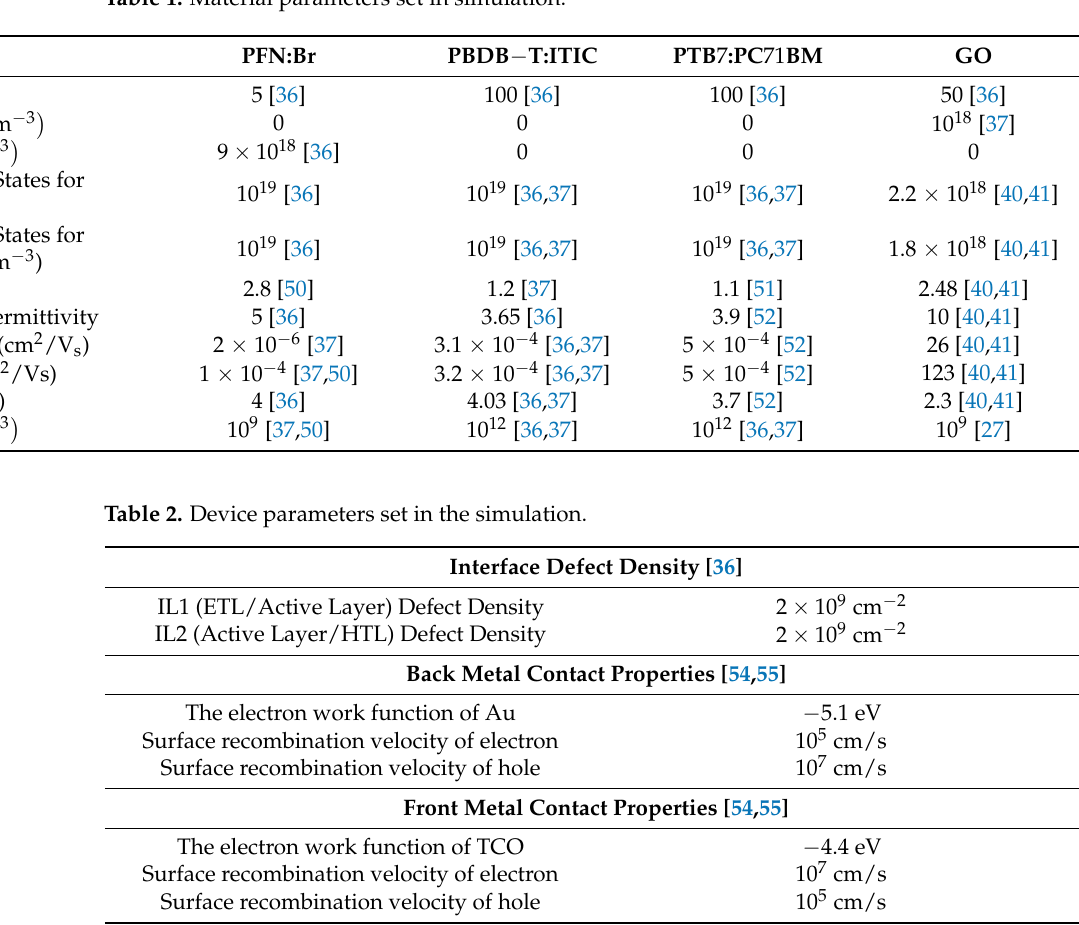
Table 2. Device parameters set in the simulation.